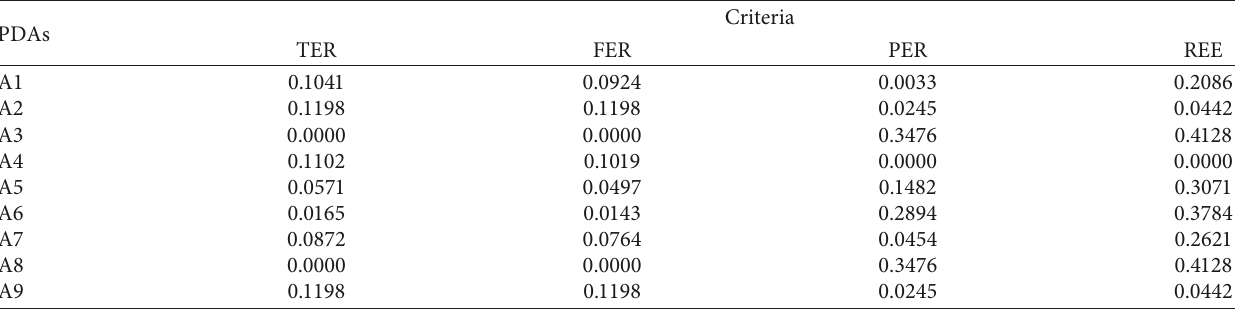
Table 12: Weighted normalized decision